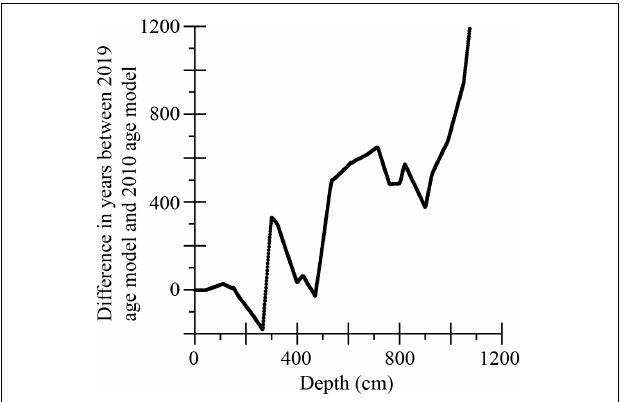
FIGURE 3 | Difference in years (cal BP) between the 2019 Elsinore Bacon v.2.2 age model and the Kirby et al. (2010) age model.